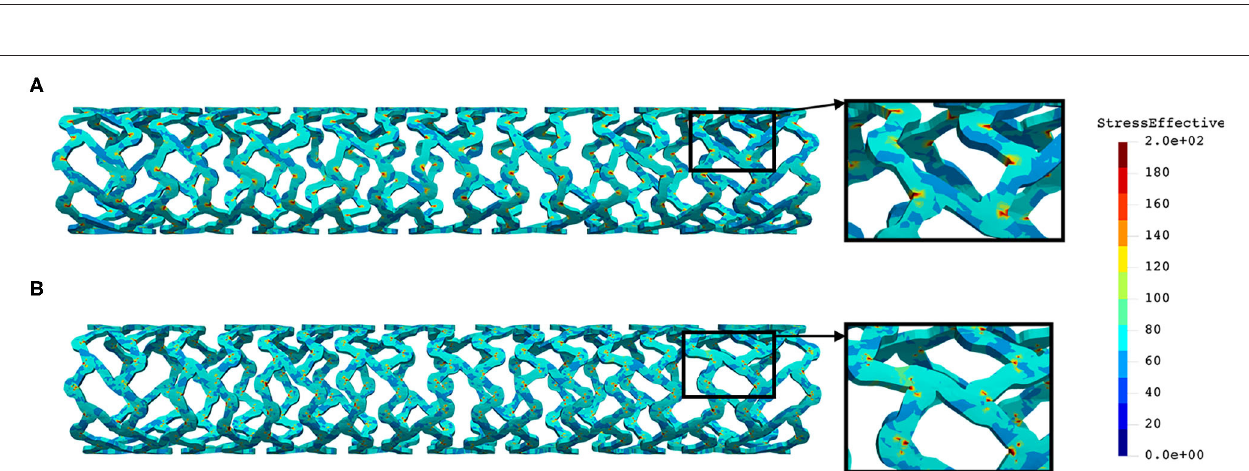
FIGURE 7 | Effective stress distribution on AB–BVS (A) and AB–BVS-thinner (B) stents for inflation test.